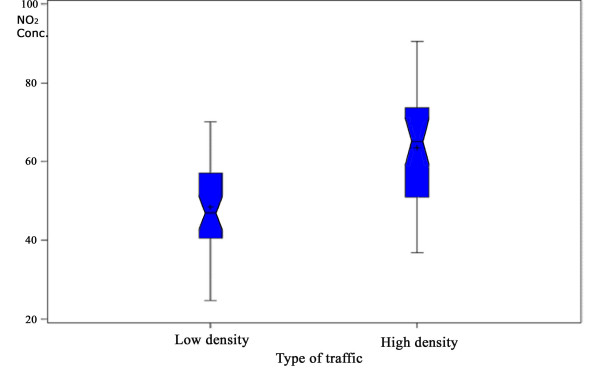
NO2 concentration according to traffic density using on-site direct observation. p = 0.005.